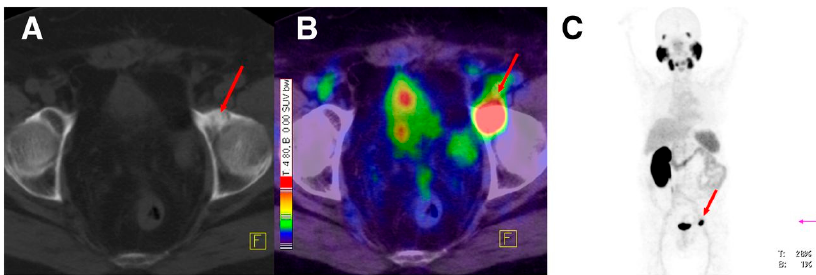
Figure 20. ( A – C ) 68 Ga-PSMA-617 PET/CT of a patient at 1 h after injection. Red arrows point to a bone metastasis with SUVmax of 21.7 at 1 h and 32.6 at 3 h after injection. ( A ) Low dose CT; ( B ) Fusion of PET and CT; ( C ) MIP of PET/CT. MIP = maximum-intensity projection (Reprinted with permission of [146]).